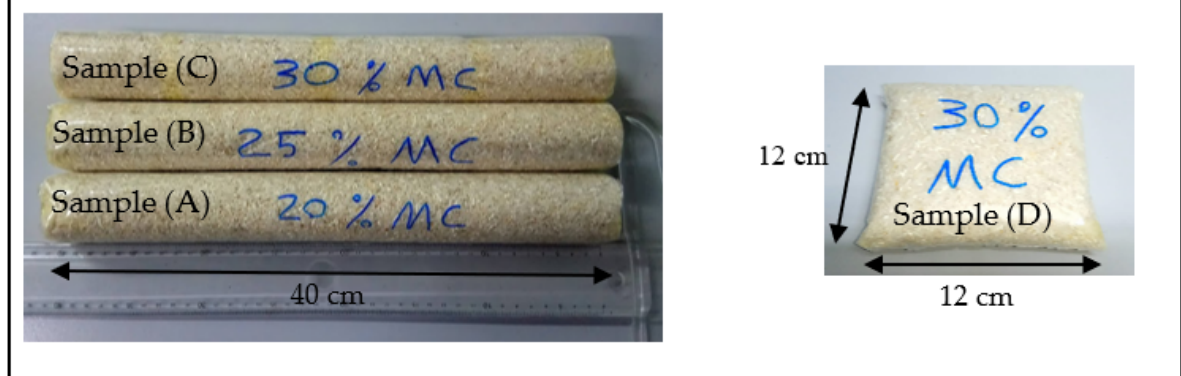
Figure 3. Samples of the rice bags with high moisture contents (MC). Table 1. Details of the physical sizes of the samples.